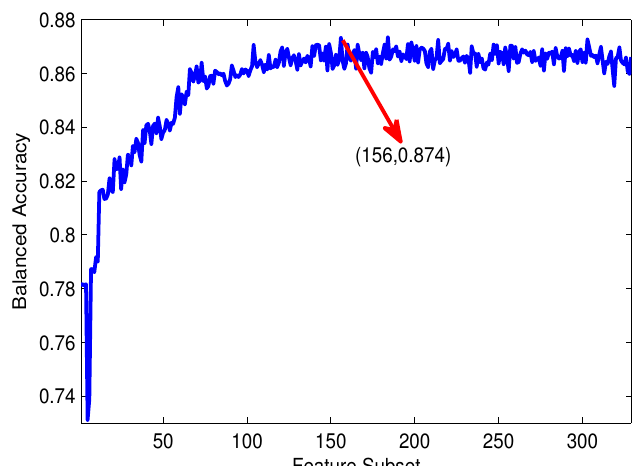
Figure 3. The IFS curve: the values of balanced accuracy against feature subsets. The maximum value of balanced accuracy is 0.874 when the top 156 features are selected. These 156 features are considered as the optimal feature set of our method.